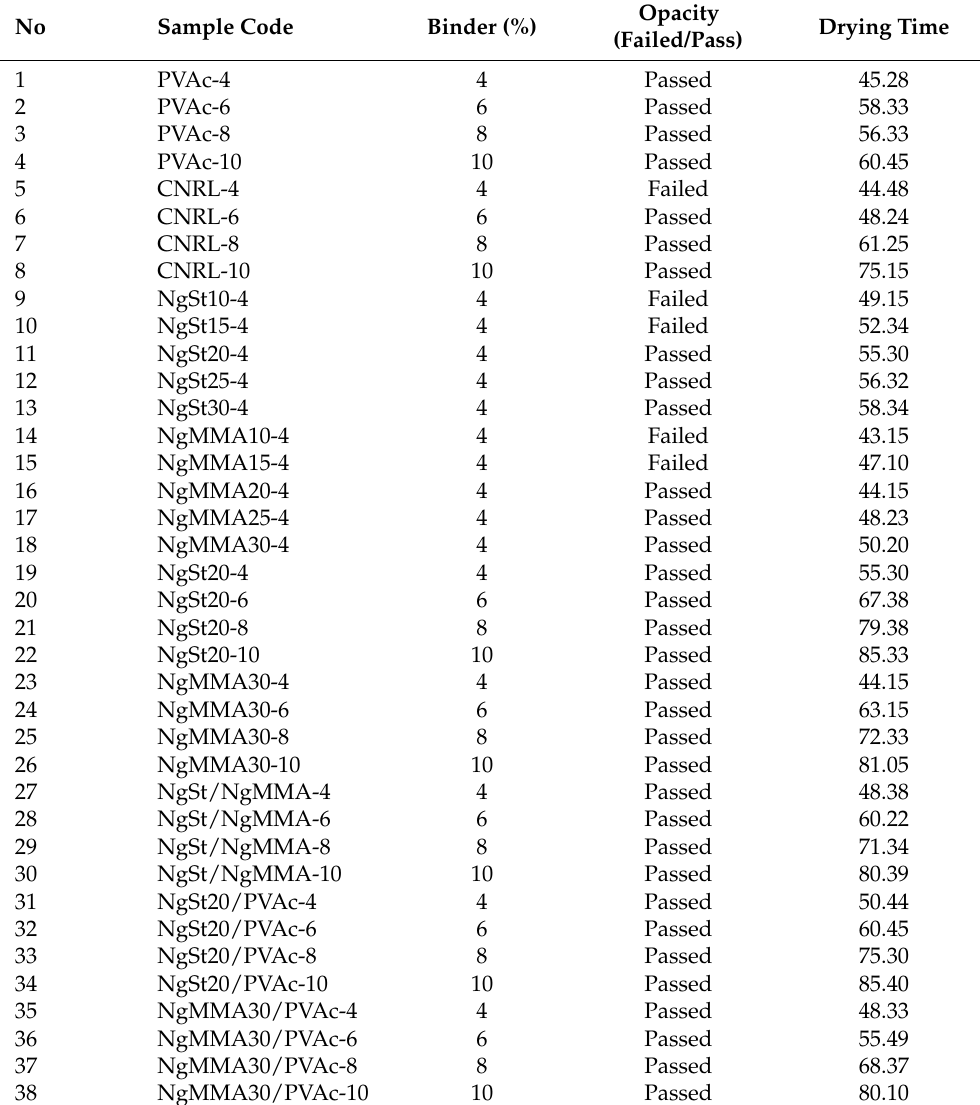
Table 4. Opacity and Drying Time of Emulsion Paints Based on NRL, NRL grafting Monomer and Combination with